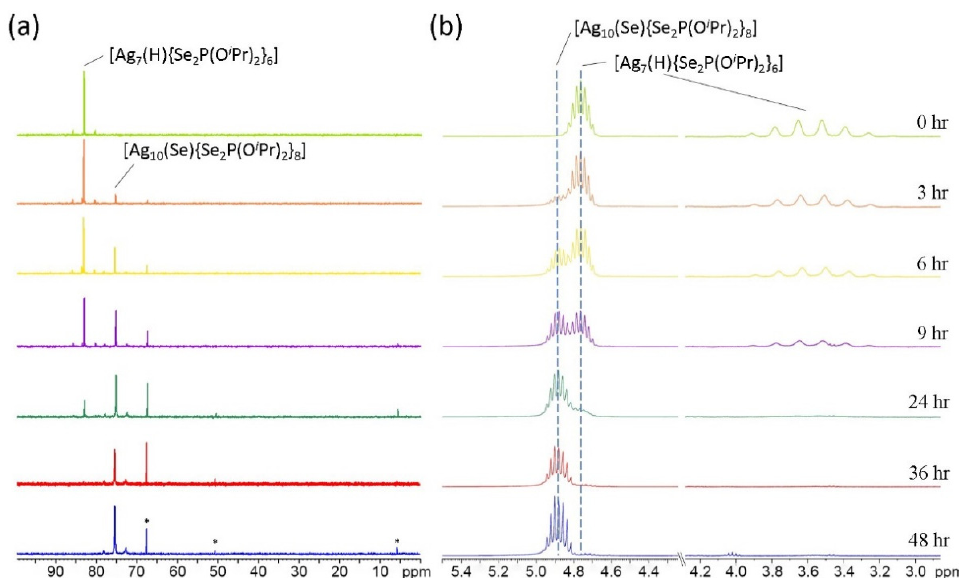
Figure 3. ( a ) Time-dependent 31 P{ 1 H} and ( b ) 1 H NMR spectrum of the reaction acquired from 0 to 48 h (asterisks denote the fragments of dsep ligands after decomposition).